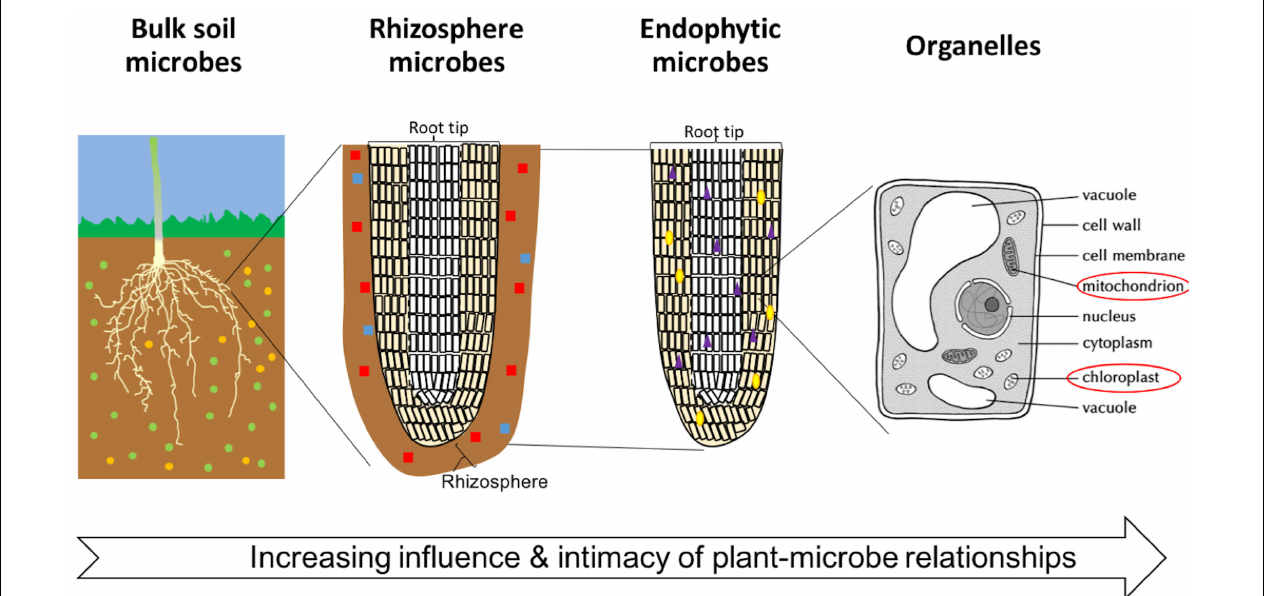
FIGURE 1 | The degree of intimacy and influence of the plant-microbe interactions. Microbes are represented by small colored (red, green, yellow, purple, and blue) shapes. Diversity and number of microbes is variable between soils, distance from plant roots, crop species, and plant